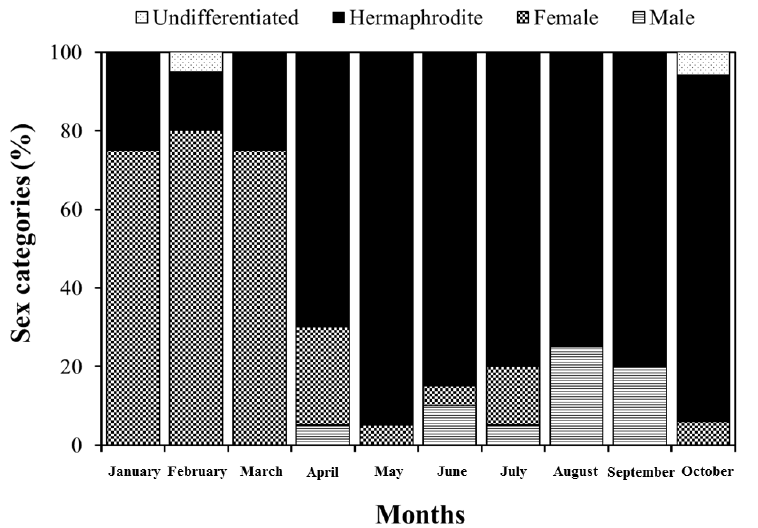
Figure 6. Distribution of sex categories of Ostrea denselamellosa collected from Tongyeong, South Korea, from January 2021 to October 2021.